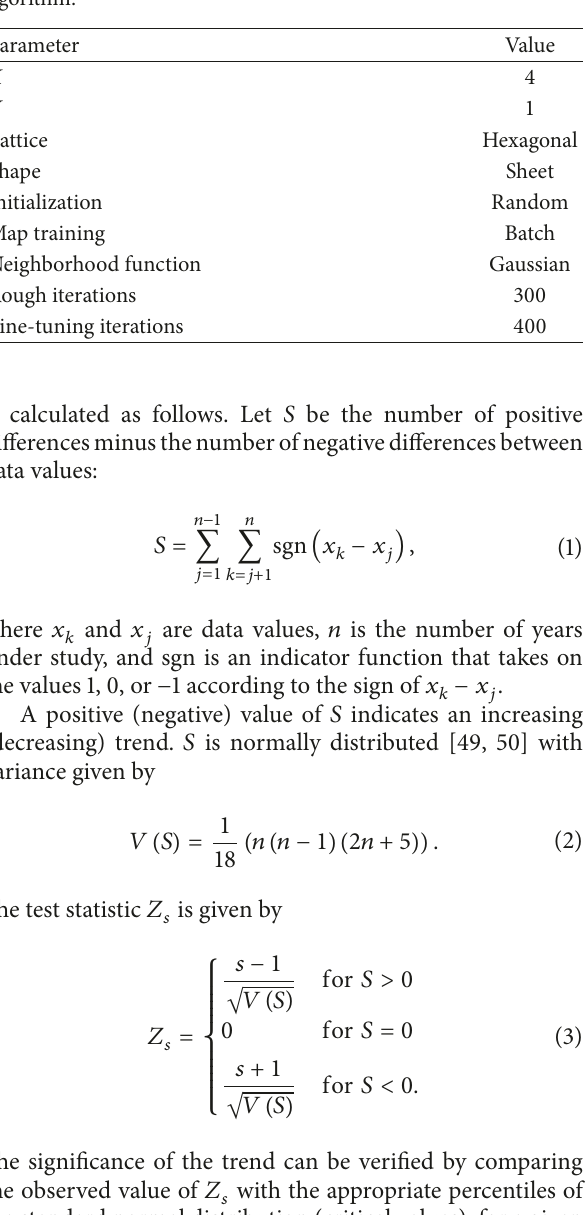
Table 2: Values of the parameters used to implement the GeoSOM